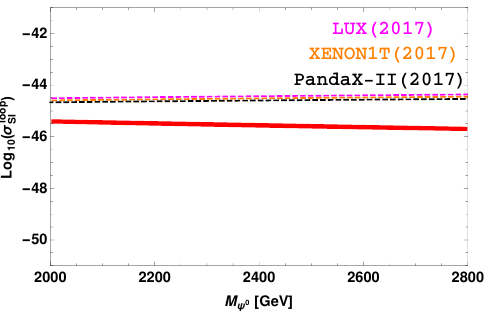
Figure 9 . One-loop SI contribution projected with the stringent upper limits of PandaX-II [188], XENON1T [189] and LUX